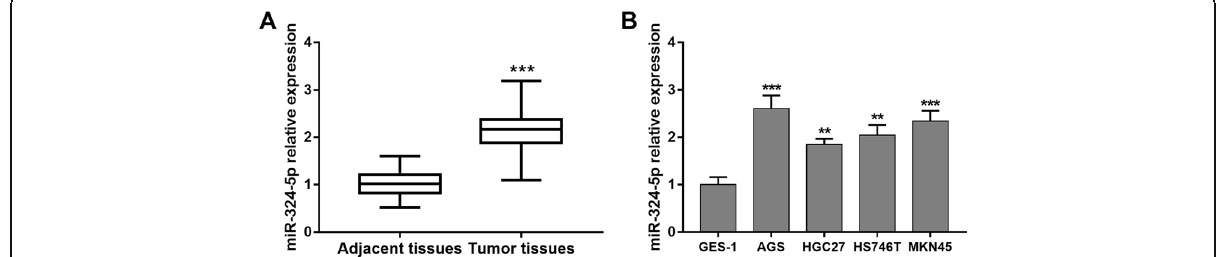
Fig. 1 Expression of miR-324-5p in GCa patients and cell lines. a . Tumor tissues had higher miR-324-5p expression than the adjacent normal tissues (*** P < 0.001). b . Expression of miR-324-5p was elevated in GCa cell lines compared with the normal cell line (** P < 0.01, *** P <